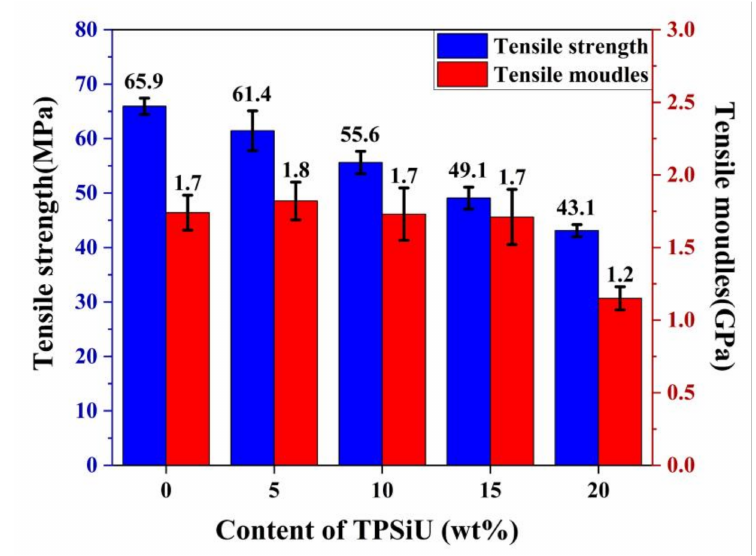
Figure 10. Tensile strength and tensile modulus for PLA/TPSiU